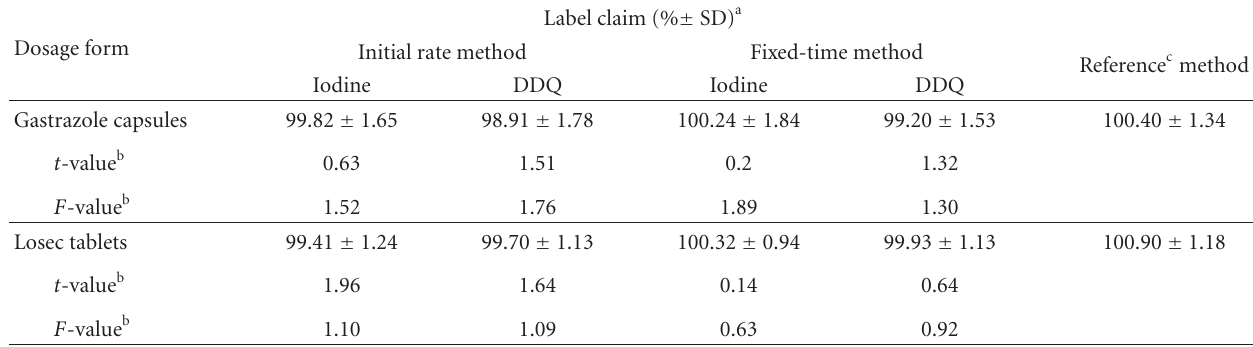
Table 7: Determination of OMZ in its dosage forms by the proposed